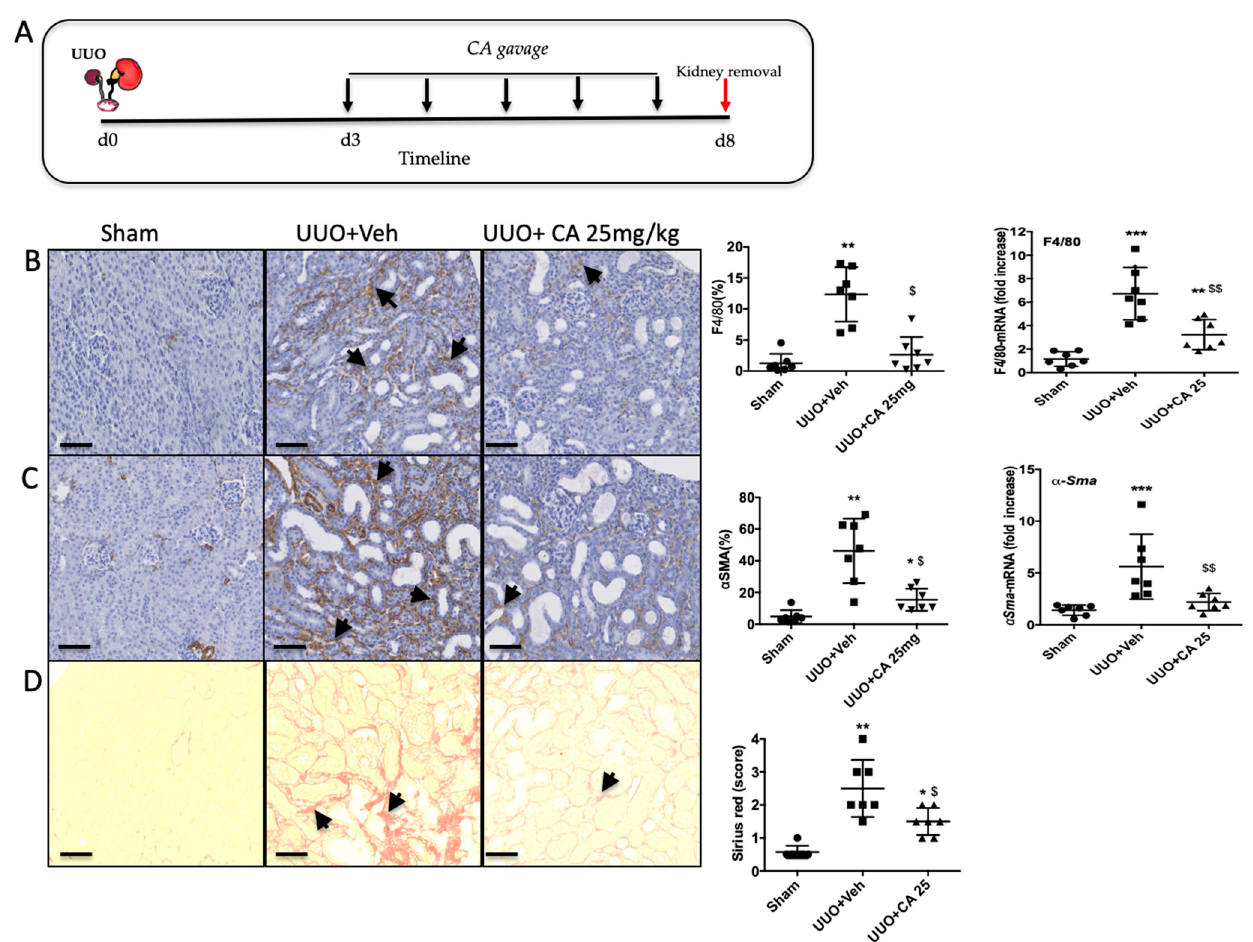
Figure 5. Curative effect of caffeic acid (CA) 25 mg/kg on renal tubulointerstitial fibrosis induced by UUO in mice. ( A ) Experiment design, black arrows indicate daily gavage with CA. ( B ) Macrophage infiltration F4/80, arrows indicate macrophages. ( C ) Accumulation of myofibroblasts alpha SMA, arrows indicate myofibroblasts. ( D ) Tubulointerstitial fibrosis (Sirius red), arrows indicate interstitial fibrosis. Sham operated group (Sham), unilateral ureteral obstruction group receiving vehicle (UUO + Veh) and unilateral ureteral obstruction group receiving caffeic acid (UUO + CA 25 mg/kg). For each staining quantitative results are shown on the right part of the figure (scatter dot plot), as well as renal mRNA expression of F4/80 and α -Sma; n = 7 per group. * p < 0.05, ** p < 0.01, *** p < 0.001, compared to Sham; $ p < 0.05, $$ p < 0.01 compared to UUO + Veh. Scale bar = 100 µm.